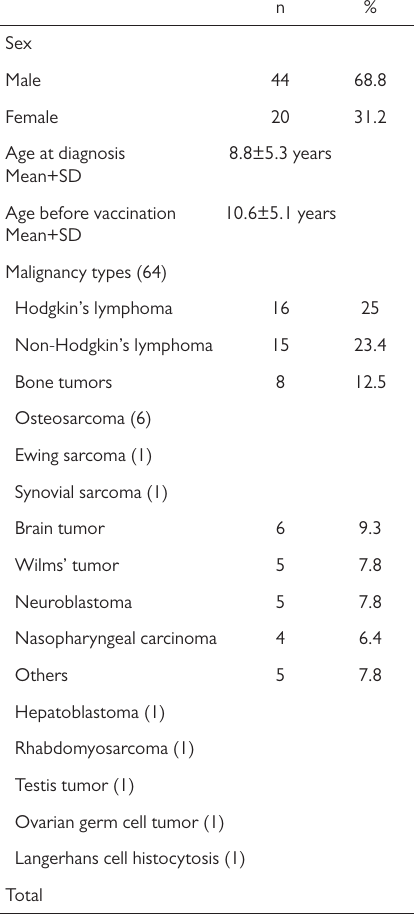
Table 1. Demographic characteristics of